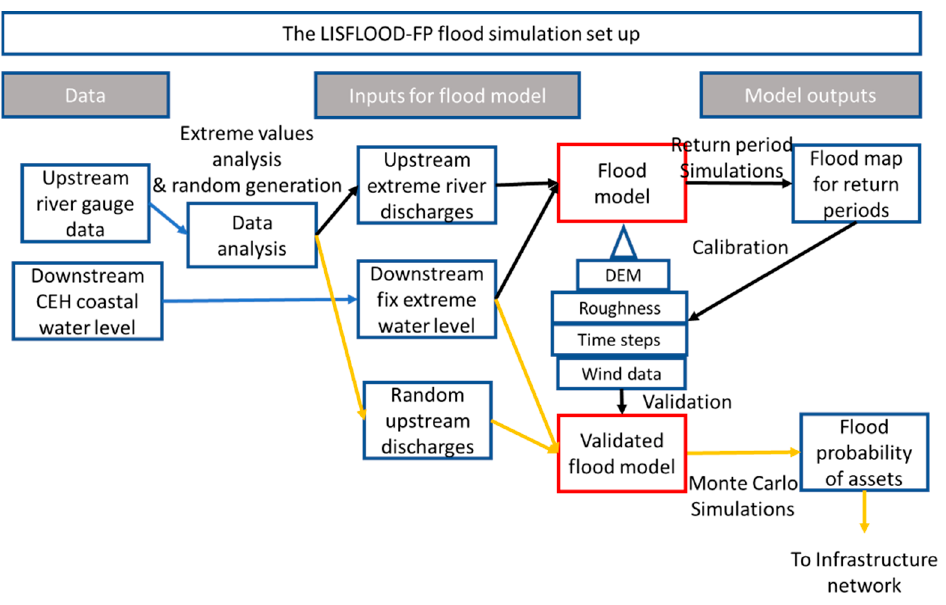
Figure A1. The flow chat of LISFLOOD-FP simulations set ups and its connection to the infrastructure network model. The black lines stand for the procedure of model calibration and validation and yellow lines indicate for Monte Carlo simulation scenarios. The red rectangles are the LISFLOOD-FP model. Table A1. The scenarios of the electricity supply disruption for the network in Figure 3.